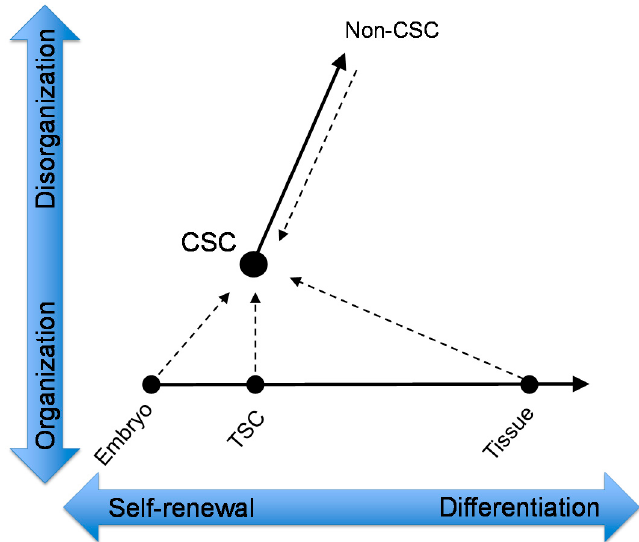
Figure 1. Schematic model of cancer stem cell (CSC) generation. The embryo undergoes a series of cleavage divisions and generates multipotent embryonic stem cells (ESCs). The ESCs generate tissue stem cells (TSCs), which are indispensable for tissue generation. The TSCs include urothelial stem cells, which produce all types of urothelial cells via differentiation. CSCs are separate from the normal differentiation process because of their lack of organization (dotted arrows). CSCs generate more differentiated cancer cells, known as non-CSCs.